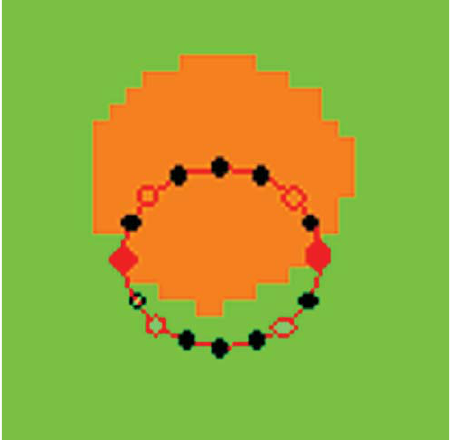
Fig. 7. The checking points of the supposed circle.